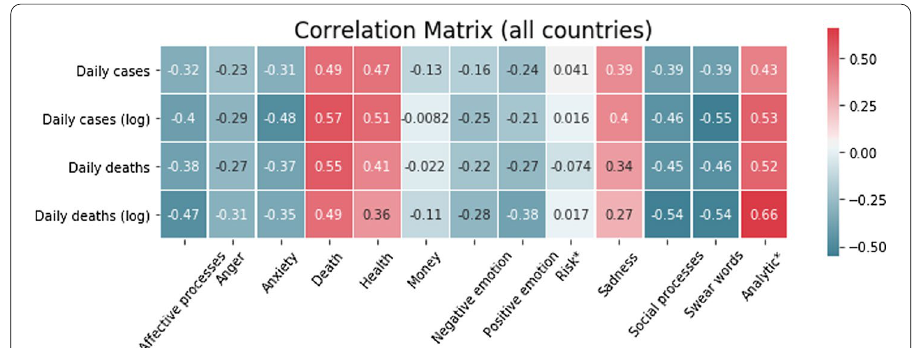
Fig. 2 Correlation coefficients between epidemiological indicators and NLSs [see Eq. (4)] averaged across all countries. * “Risk” and “Analytic” are only available for the English-language LIWC. These two categories are thus averages across English-language countries